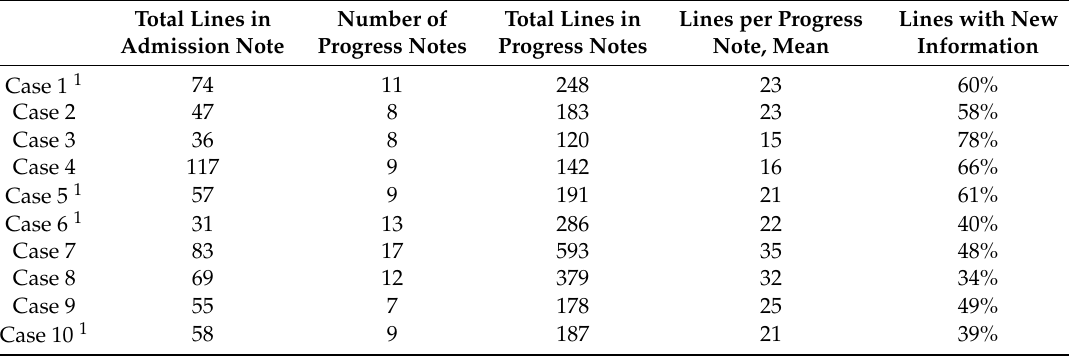
Table 1. Characteristics of the clinical notes selected for